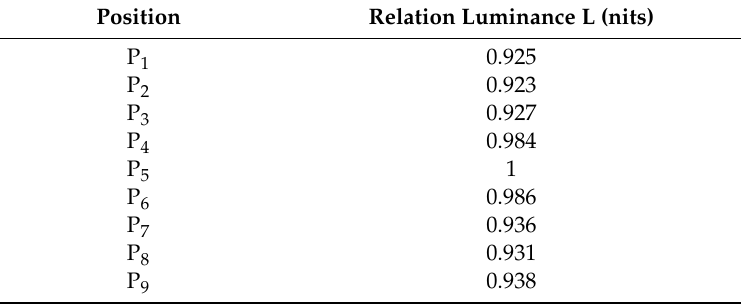
Table 7. Optical characteristics of light source and light source